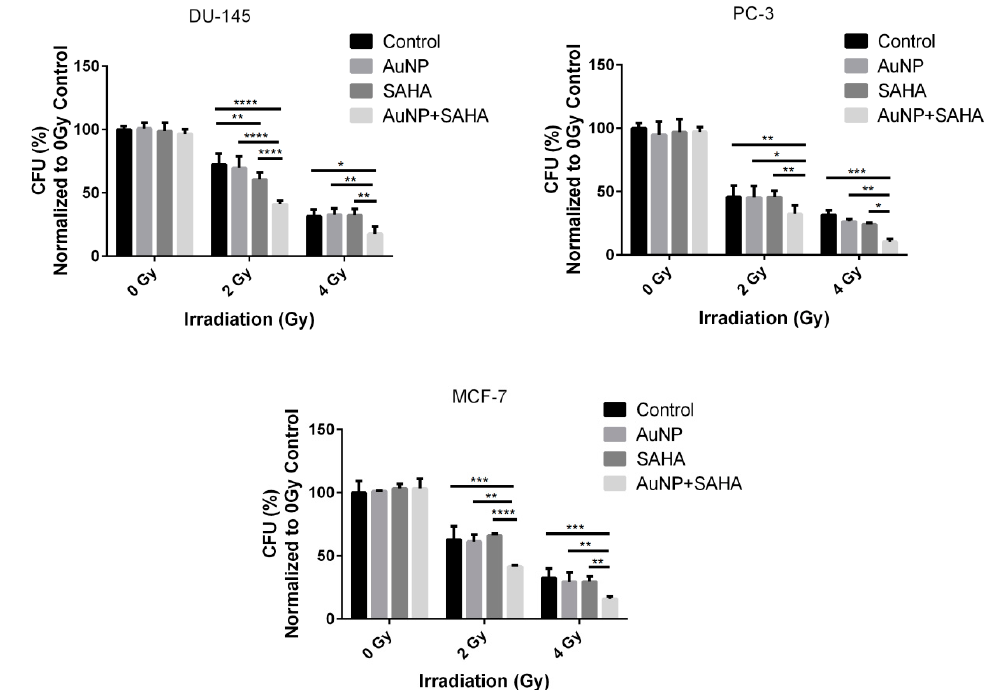
Figure 6. The combinational treatments affect the colony forming capacity of cancer cells upon irradiation. The AuNP + SAHA double treatments significantly decreased the colony forming capabilities of DU-145, PC-3 and MCF-7 cells after 2 and 4 Gy dose irradiation. (* p value < 0.05; ** p value < 0.01; *** p value < 0.001; **** p value < 0.0001; two-way ANOVA Tukey’s multiple comparisons test).